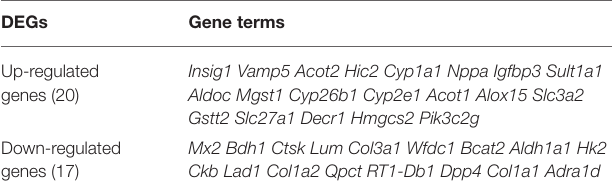
TABLE 2 | Common differentially expressed genes in GSE4745 and